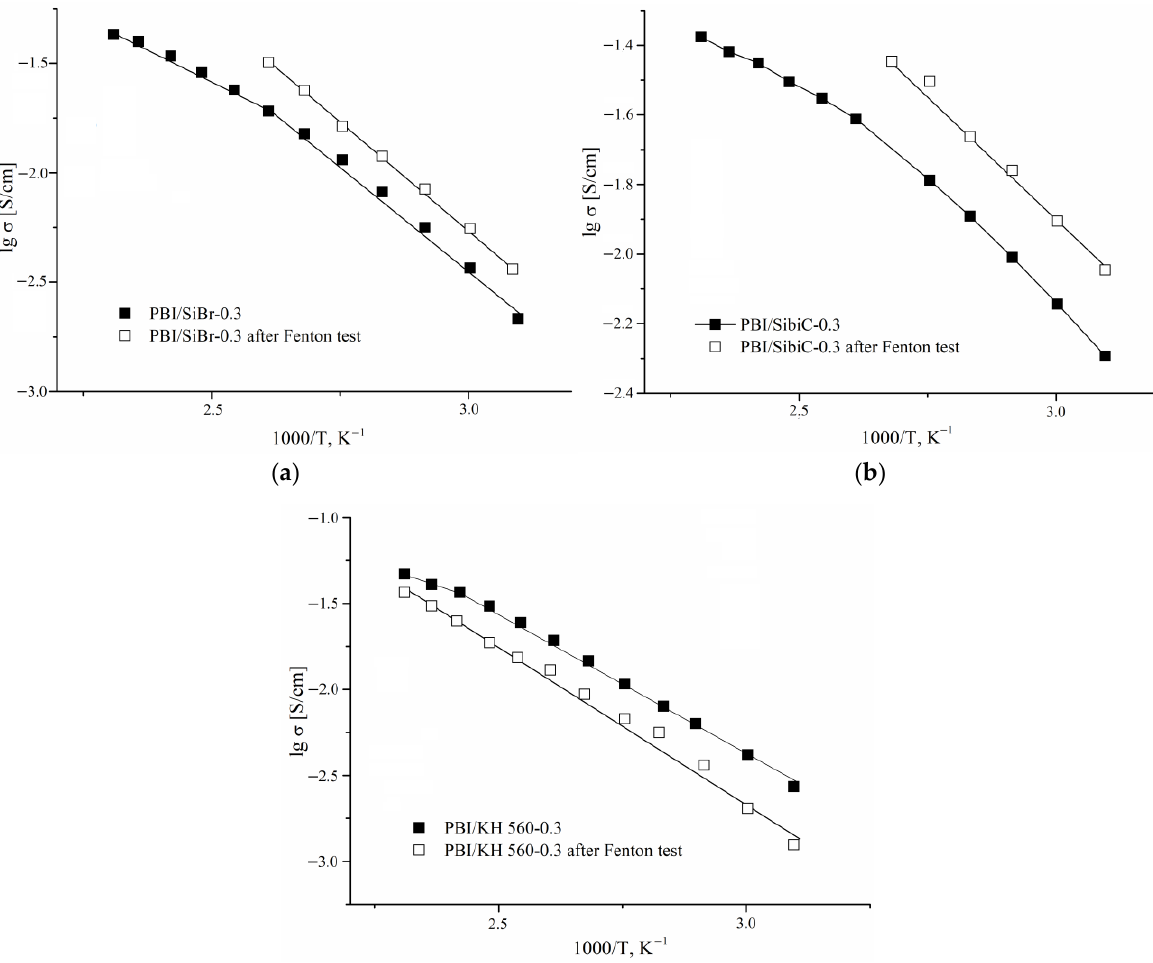
Figure 8. Conductivity temperature dependence for membrane samples after testing under oxidizing conditions with Fenton ’ s reagent. SiBr ( a ), SibiC ( b ) and KH 560 ( c ) were used as crosslinking reagents. For comparison, the data of samples not treated with Fenton ’ s reagent are given.